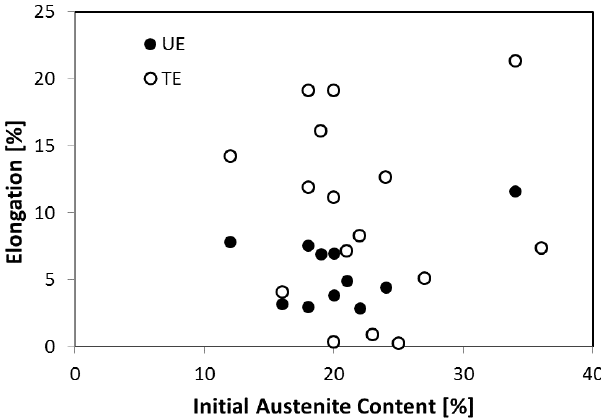
Figure 8. Values of total and uniform elongation, TE and UE, respectively, vs. the initial austenite content. Adapted from reference [9,42].